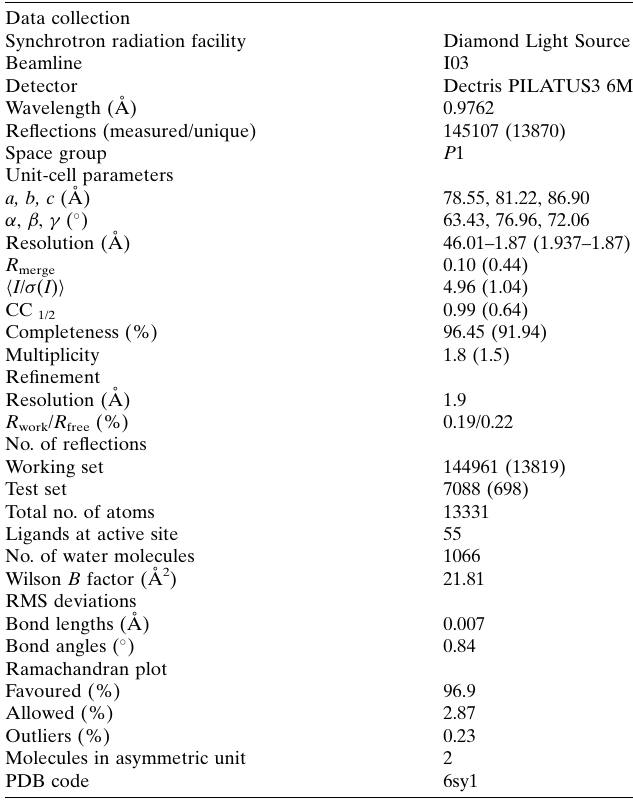
Table 1 Summary of diffraction and refinement statistics. The numbers in parentheses represent data in the highest-resolution